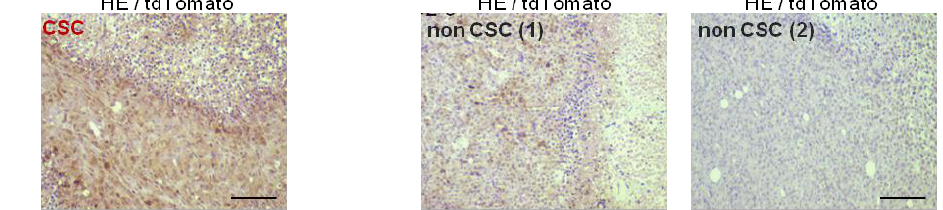
(immunohistochemistry) (HE / td Tomato) in representative tumors of animals inoculated with CSC-like cells, and non-CSC (tdTomato positive as well as the tdTomato negative example). Magnification